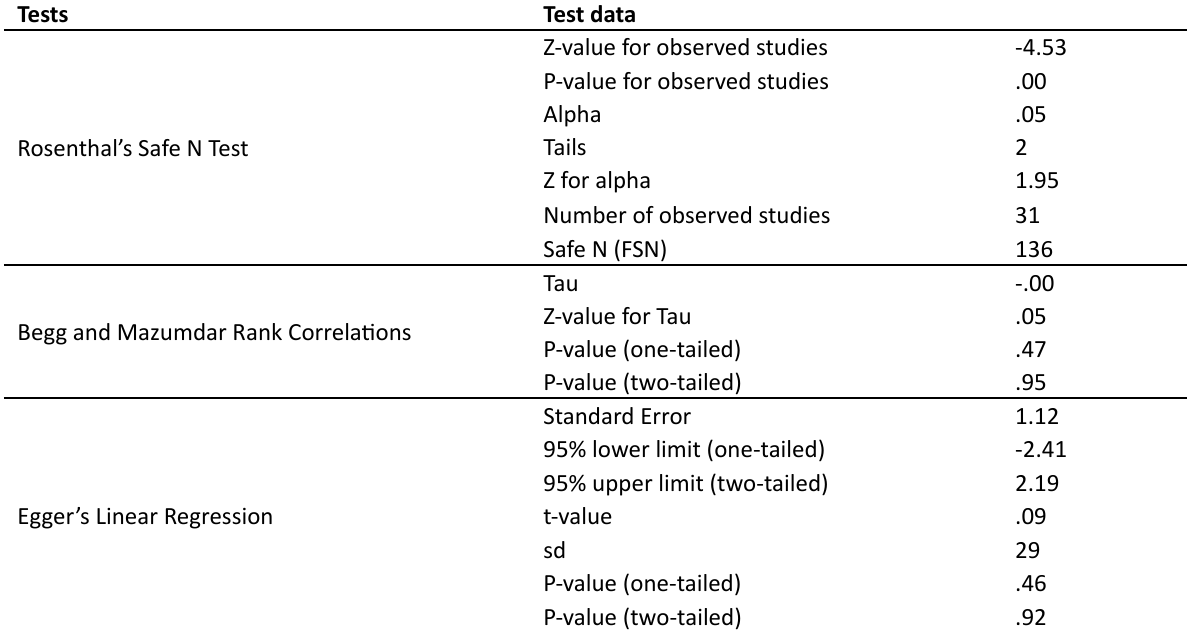
Figure 2. A funnel plot of effect sizes of studies on the impact of gender on nutrition knowledge levels of physical education and sports stakeholders Table 1. Tests results for publication bias of studies subjected to meta-analysis